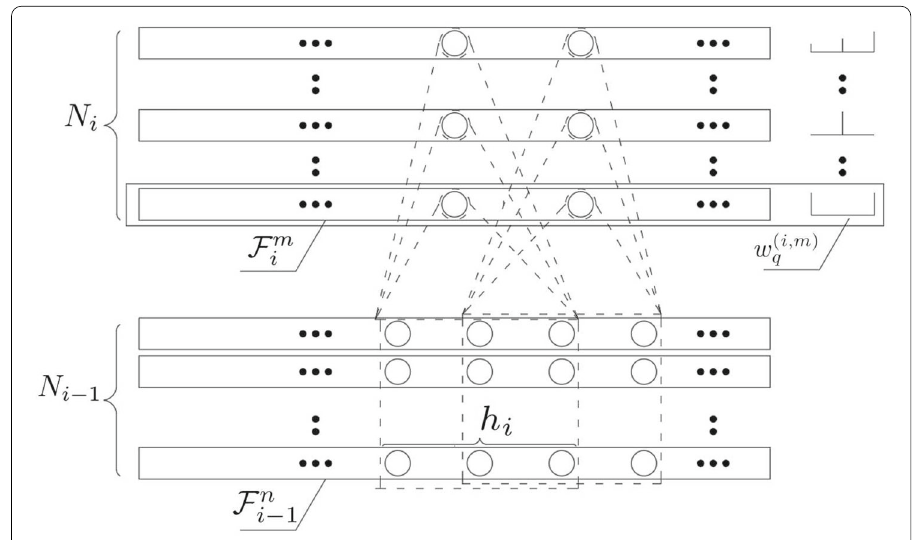
Fig. 4 Sketch of a 1D convolutional layer. Here h i specifies the kernel dimension. As a filter is associated to each feature map n , to represent it bars of different heights are used in relation to the amplitude of the filter